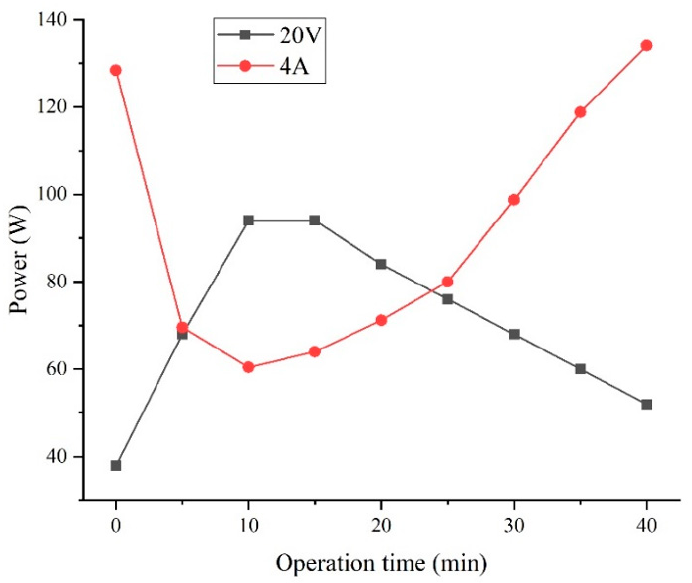
Figure 9. Power of the device under different operation conditions.